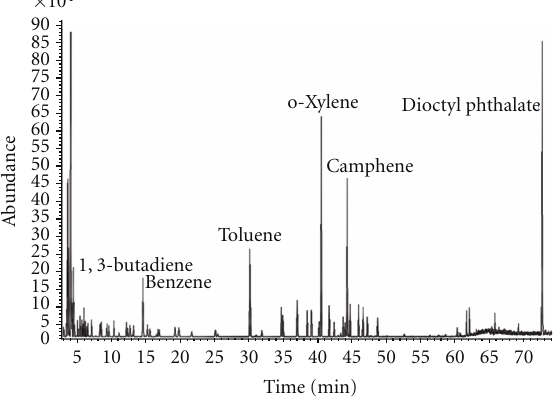
FIGURE 2: Tube desorption (TD-100, Markes International Ltd) demonstrating simultaneous analysis of a wide range of compounds relevant to materials emissions testing (method conditions are shown in Table 1).